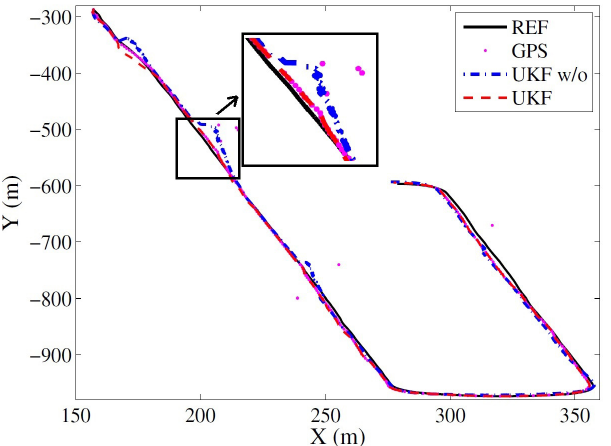
Figure 10. The estimated trajectories by the UKF-based methods with or without the jump detection strategies with random noises in the GNSS measurements against the reference.